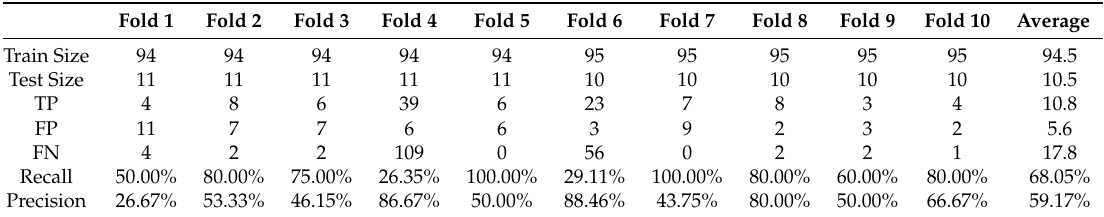
Table A12. The Results of Experiment 12: Augment 50% of dataset containing images with and without dents (Dataset 5), by testing with the pre-classifier.